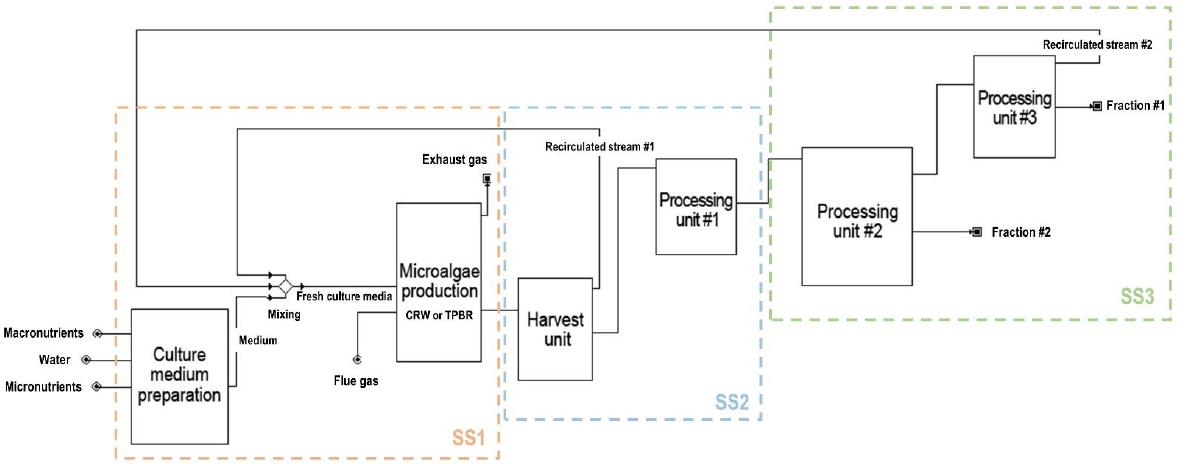
Figure 2. Simplified flowchart of the model developed in SuperPro Designer for biomass production and downstream processing of the three studied microalgae strains. The microalgae production system (CRW or TPBR) varies according to the species being produced.